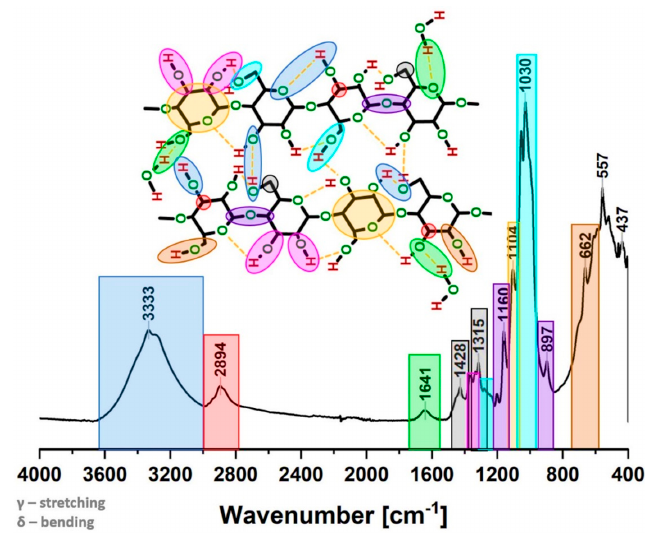
Figure 2. Exemplary Fourier-transform infrared spectra for a sample tested after 24 h of moisture absorption in the desiccator filled with saturated solution of KNO 3 (RH = 96%). Chemical moieties assigned to the particular frequencies. Table 1. Tabularized values of wavenumber attributed to the chemical moieties.